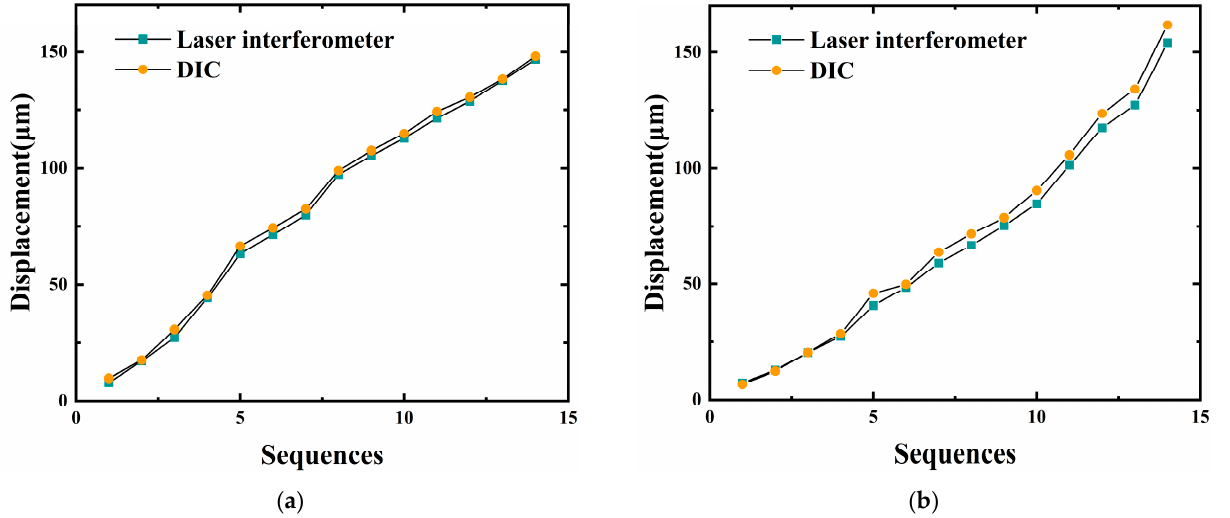
Figure 6. Displacement measurement results ( a ) in-plane displacement ( b ) out-of-plane displace- ment.